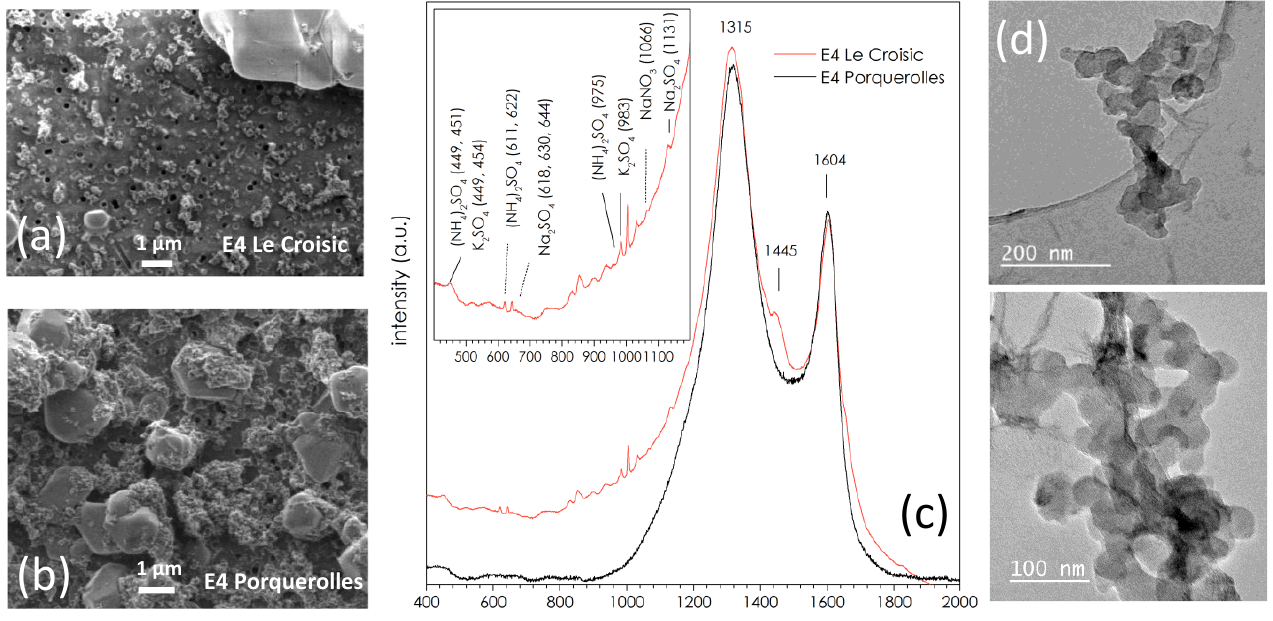
Figure 7. ( a ) High magnification SEM image of the E4 stage (D50% = 0.17 µm) of the C4 sample from Le Croisic and ( b ) the P1 sample from Porquerolles. ( c ) Raman spectra of the same samples, carried out on the aluminum part of the E4 stages. ( d ) TEM image of soot aggregates extracted from the E4 filter of P1.